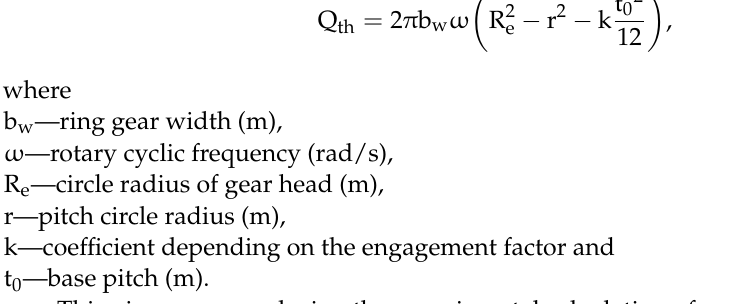
Figure 3. Flow ripple compared to the kinematic flow at 200 bar and 20 bar (simulated based on the external gear pump with 2000 RPM and VT circuit). Data from open-source journal [21].